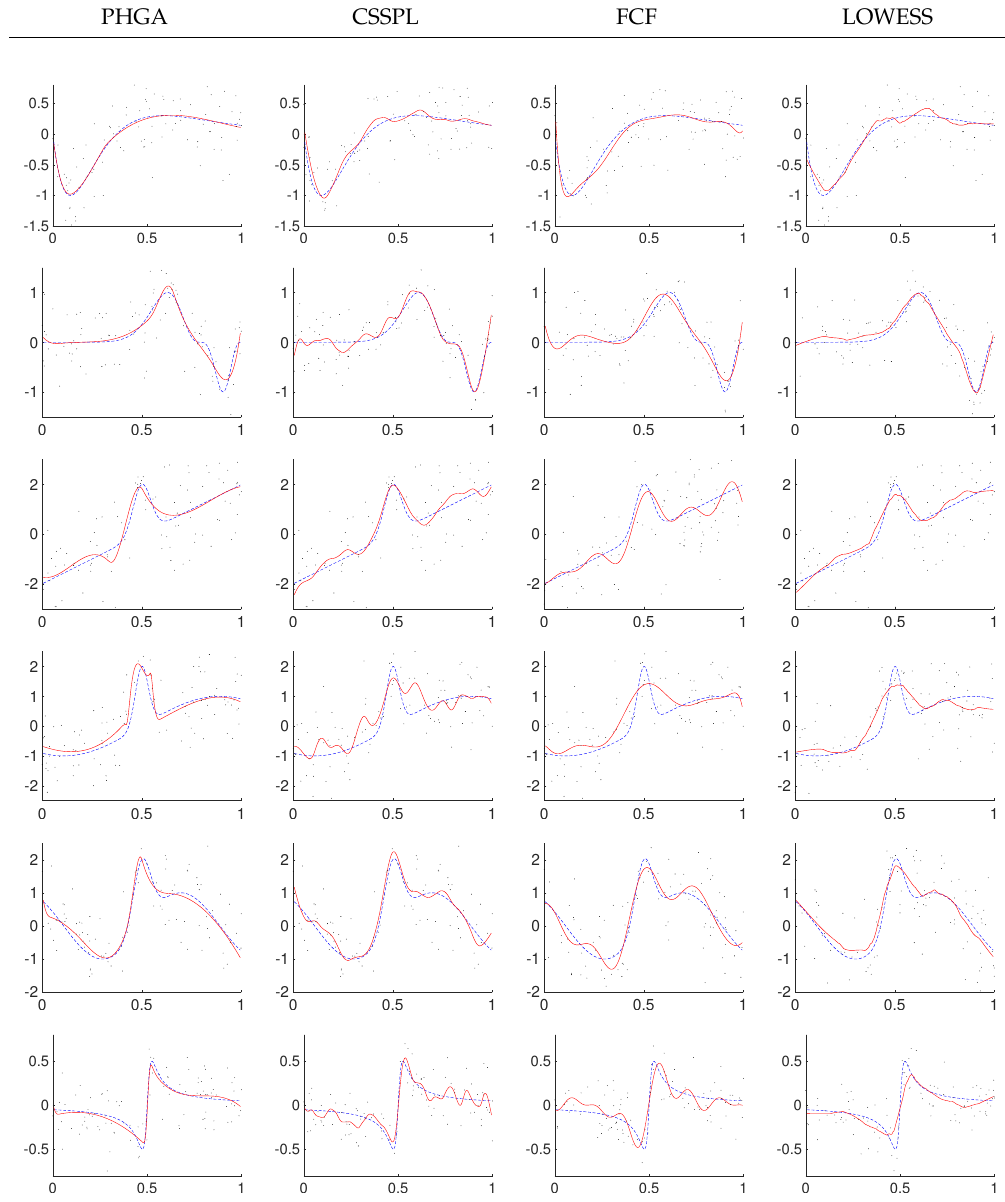
Figure 9. Data and best fitting with SNR = 1 for PHGA, CSSPL, FCF and LOWESS methods (solid line: estimated function; dashed line: real function). Table 5. Average time execution in seconds and